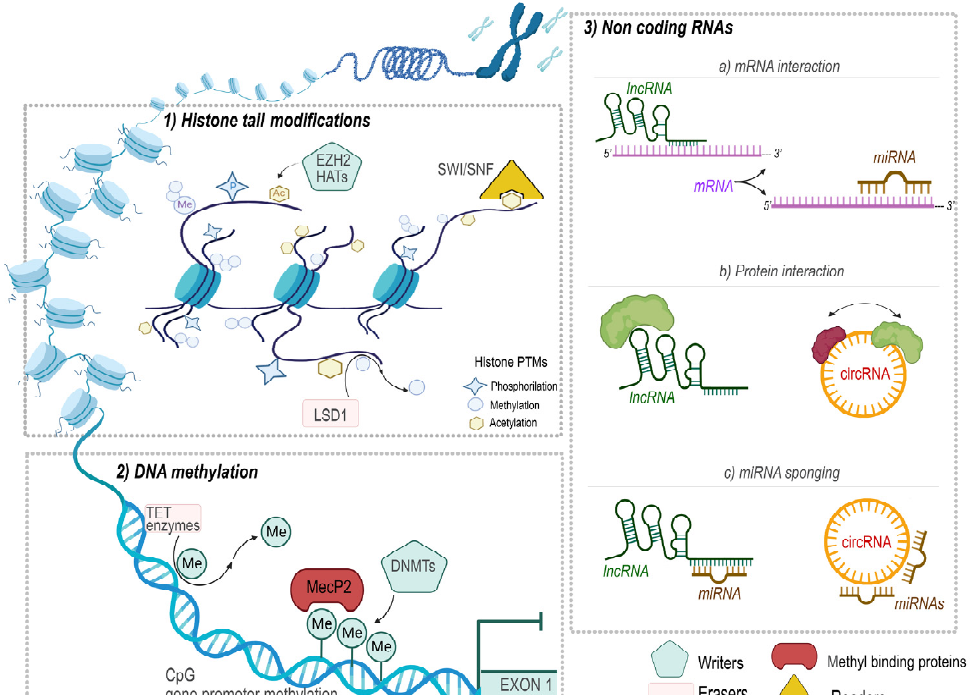
Figure 1. The epigenetic mechanisms and the key players (writers, erasers, readers, and methyl- binding proteins) of the epigenetic regulation are shown in Figure 1. ( 1 ) Post-translational modifica- tions (PTMs) occur at the level of histone tails and influence the chromatin accessibility to various transcription factors. Among the modifications that could occur, acetylation and methylation are some of the best characterized. Moreover, the figure shows examples of the writer enzymes enhancer of zeste homolog 2 methyltransferase (EZH2) and histone acetyltransferases (HATs), which promote, respectively, methylation and acetylation on histone tails, which are read by specific enzymes, such as SWI/SNF, an H3K27 acetylation reader. Finally, lysine specific demethylase 1 (LSD1), among several others, is the enzyme responsible for the removal of histone modifications, and particularly some methylation marks. ( 2 ) DNA methylation occurs at level of the C5 position of the cytosine. Methyl groups are added by specific DNA methyltransferases family enzymes (DNMTs), erased by the ten- eleven translocation methylcytosine dioxygenases (TET enzymes), and read by methyl CpG-binding proteins, such as MeCP2. ( 3 ) Non-coding RNAs can be divided in various classes based on their length and structure. The figure shows microRNAs (miRNAs), long non-coding RNAs (lncRNAs), and circular RNAs (circRNAs). NcRNAs orchestrate different mechanisms, including: ( a ) post- transcriptional gene regulation through the interaction with the untranslated region of the mRNAs and the sequestering of them; ( b ) both lncRNAs and circRNAs could interact with the cytoplasmatic proteins influencing their half-life or promoting the interaction between proteins; ( c ) ncRNAs could bind other ncRNA species (miRNAs sponging) inhibiting/promoting their